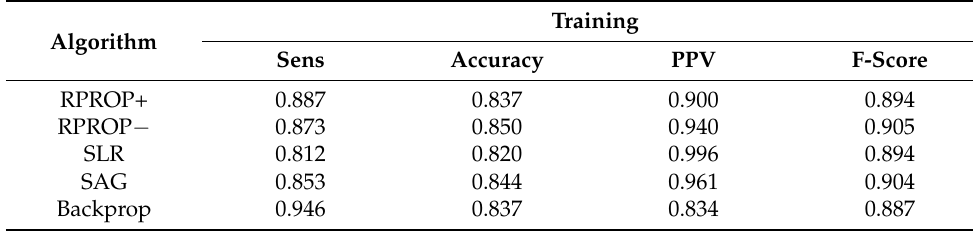
Table 8. Statistical evaluation parameters (training).